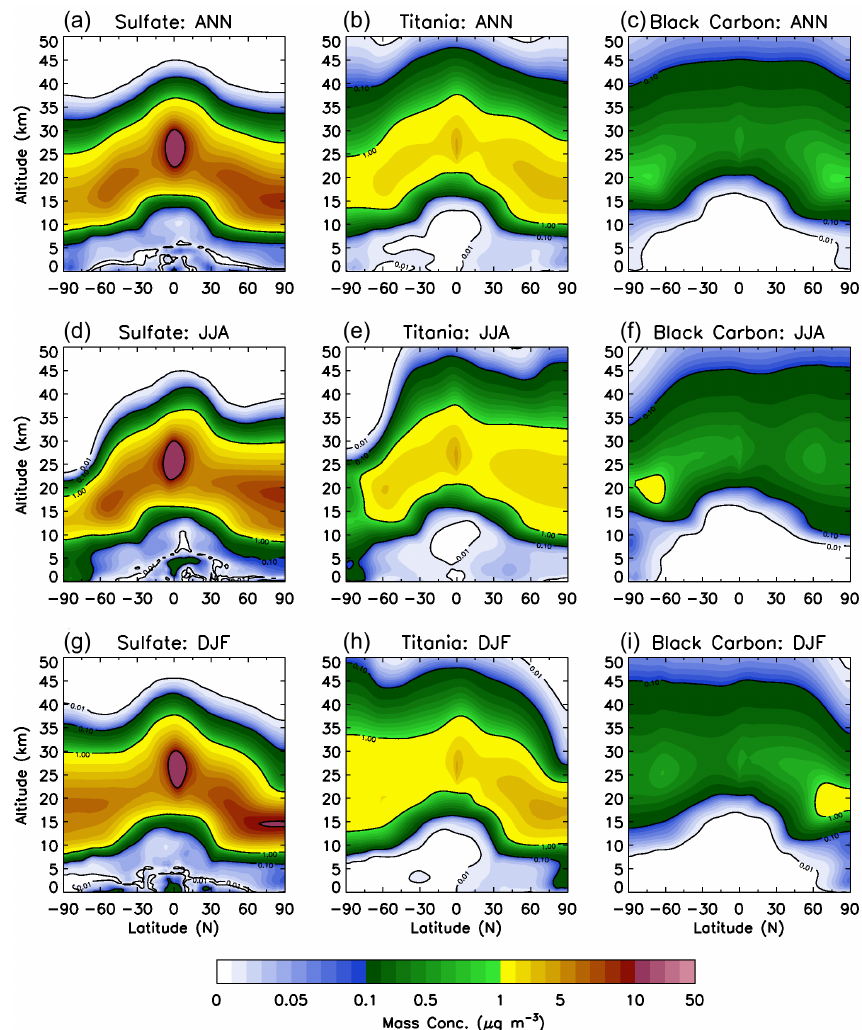
Figure 4. Annual and seasonal zonal-mean mass concentration anomalies for sulfate (geoSulf-left), titania (geoTiO 2 -center) and black carbon (geoBC –